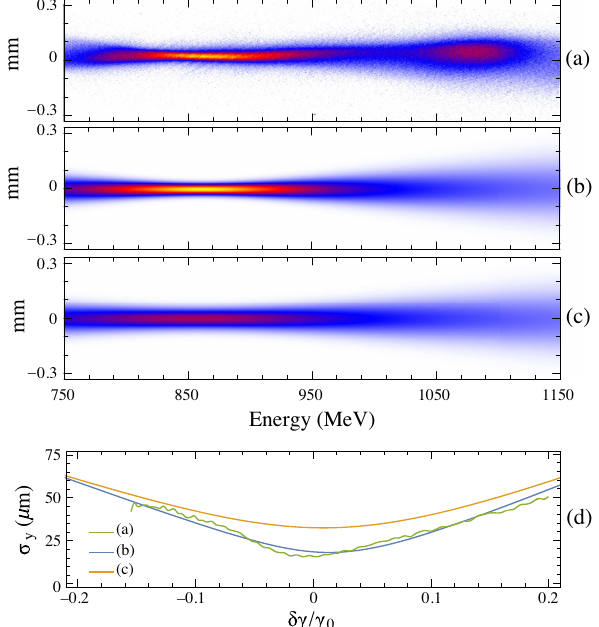
FIG. 5. Characteristic “ bowtie ” measurement of transverse electron distribution vs energy (a). Simulation using particle tracking and assuming a carbon based scatterer between the LPA and APL with thicknesses of 20 nm (b) and 20 μ m (c). Energy dependent beam size vs energy (d) for the measurement in (a) (green line), the simulation in (b) (blue line), and the simulation in (c) (yellow